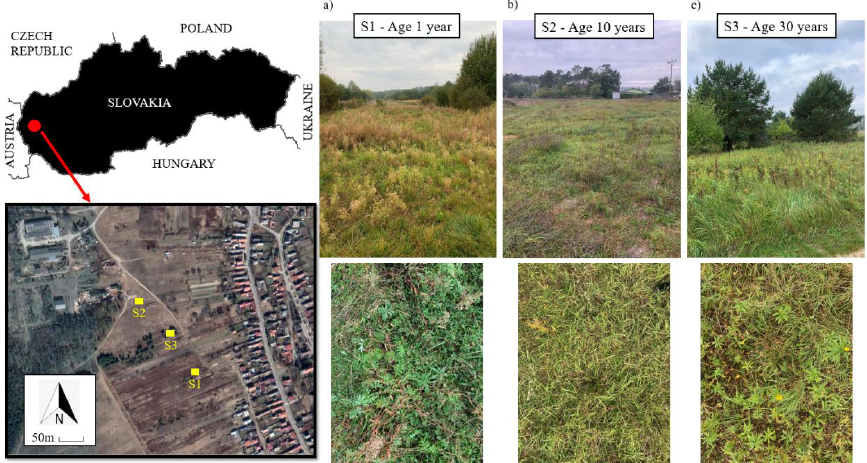
Figure 1. Location and areal view of the studied area with experimental sites S1 ( a ), S2 ( b ), and S3 ( c ) located at Studienka village in the Borsk á n í žina lowland (southwestern Slovakia). Study site S1 (48 ◦ 31 (cid:48) 37 (cid:48)(cid:48) N, 17 ◦ 7 (cid:48) 54 (cid:48)(cid:48) E; 173 m a.s.l.) is arable land with flat